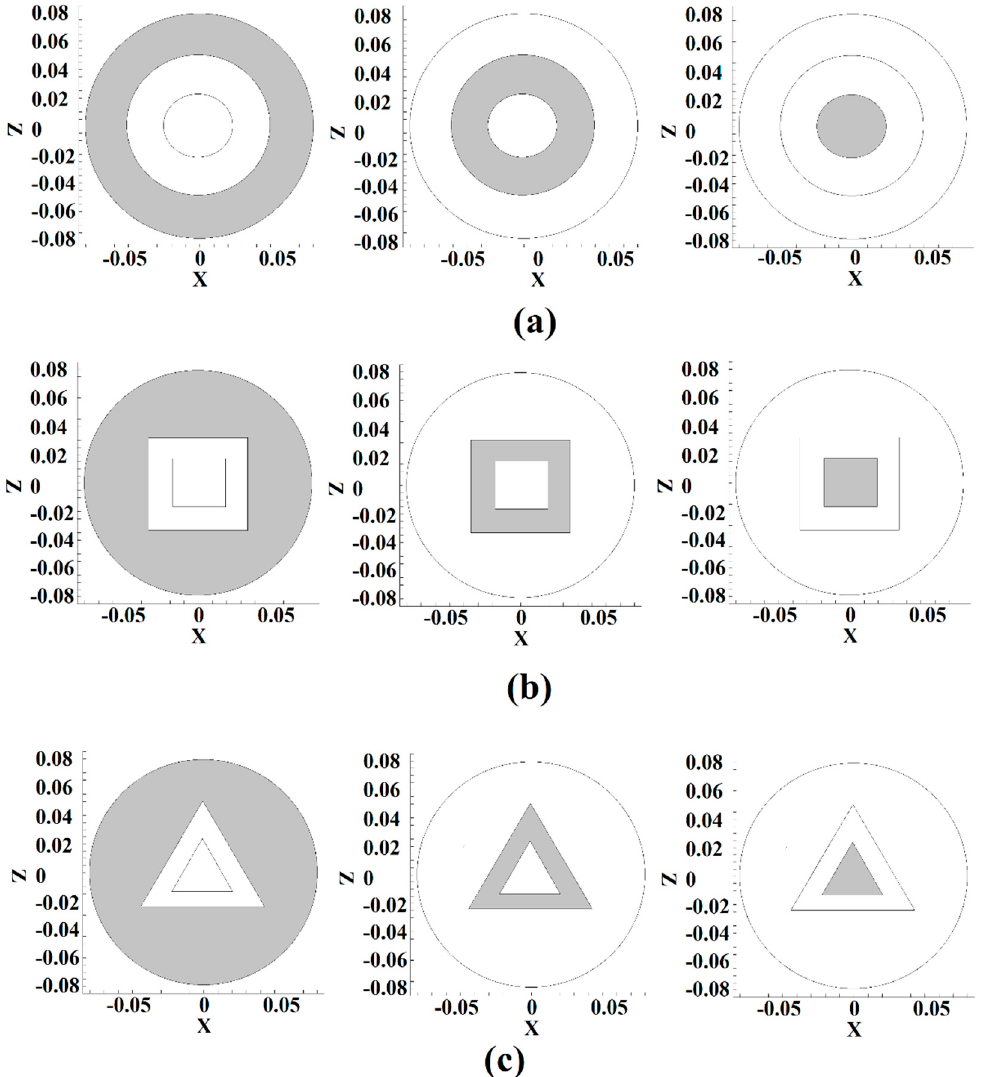
Figure 5. Shoulder, pin body, and pin bottom area for ( a ) FPT, ( b ) CPT, and ( c ) TPT. All tools have a shoulder–workpiece, pin body–workpiece, and pin bottom–-work- piece contact area. Figure 5a–c indicated different parts of the tool in contact with the base metal for FPT, CPT, and TPT pins, respectively. The geometrical analysis of the different tools is presented in Table 1. Table 1. Comparison between the area of tools and heat generation rate.